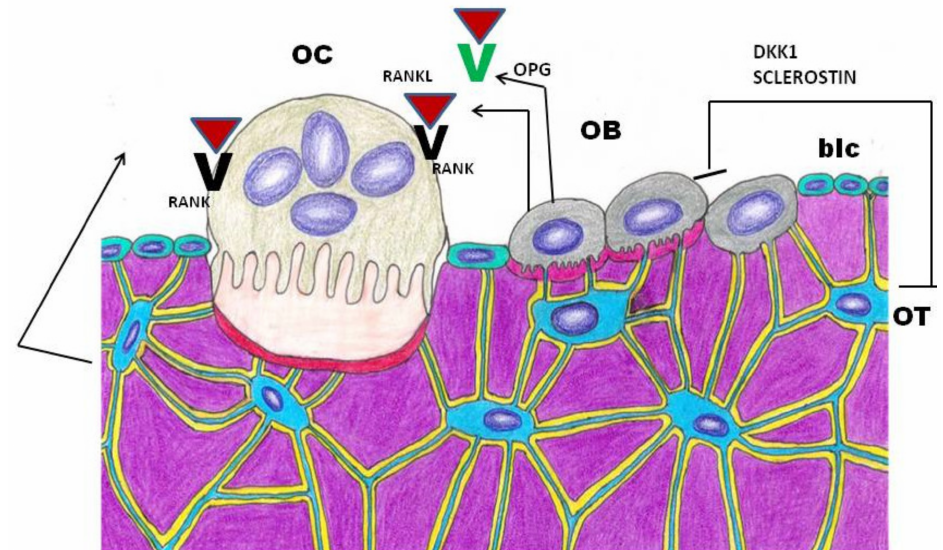
Figure 1. Schematic representation of Osteoclast/Osteoblast/Osteocyte cross-talk mediators involved in bone remodeling. OC: osteoclast; OB: osteoblast; OT: osteocyte; blc: bone lining cell. DKK1: Dickkopf WNT signaling pathway inhibitor 1; RANKL: Receptor activator of nuclear factor kappa- B ligand; RANK: Receptor activator of nuclear factor kappa-B; OPG: osteoprotegerin, a RANKL decoy